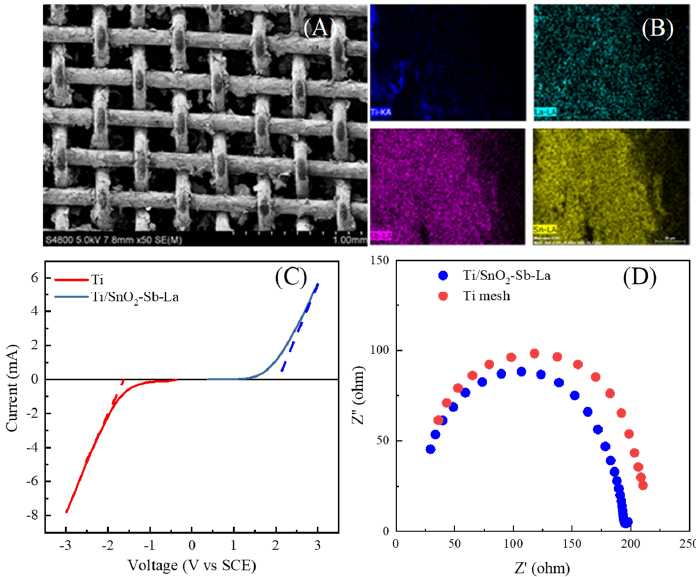
Figure 2. ( A ) SEM image and ( B ) EDS mapping of the Ti/SnO 2 -Sb-La electrode; ( C ) linear sweep voltammetry (LSV) and ( D ) Nyquist plot of electrochemical impedance spectroscopy (EIS) of Ti/SnO 2 -Sb-La electrode in a 5 mM Na 2 SO 4 solution.